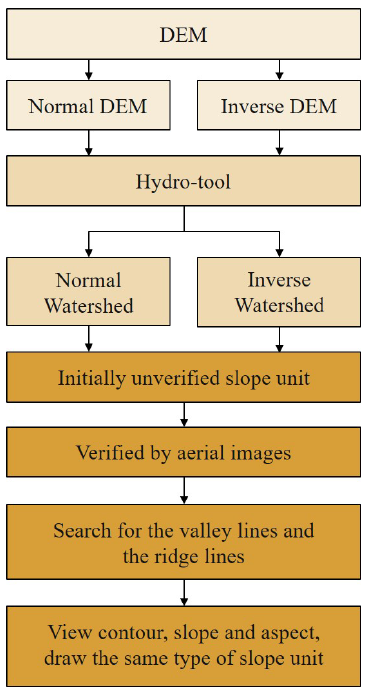
Figure 3. Process of delimited slope units (modified from Wang et al., 2016).